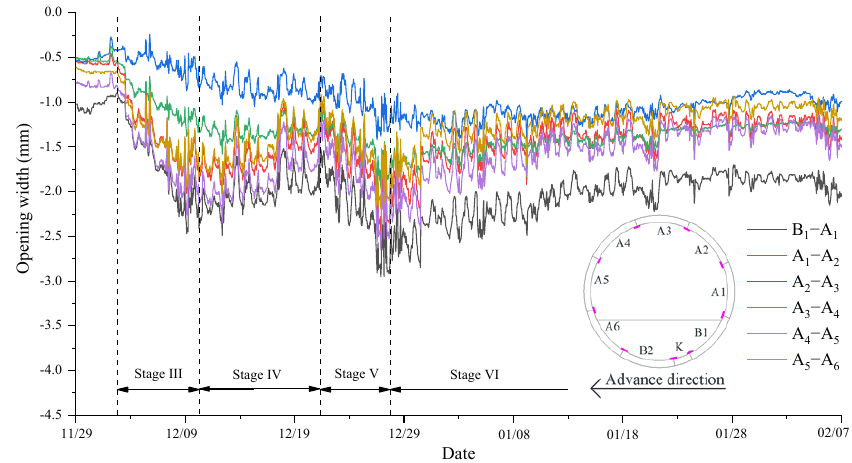
Figure 12. The opening width of the segment joint versus time at CS12.